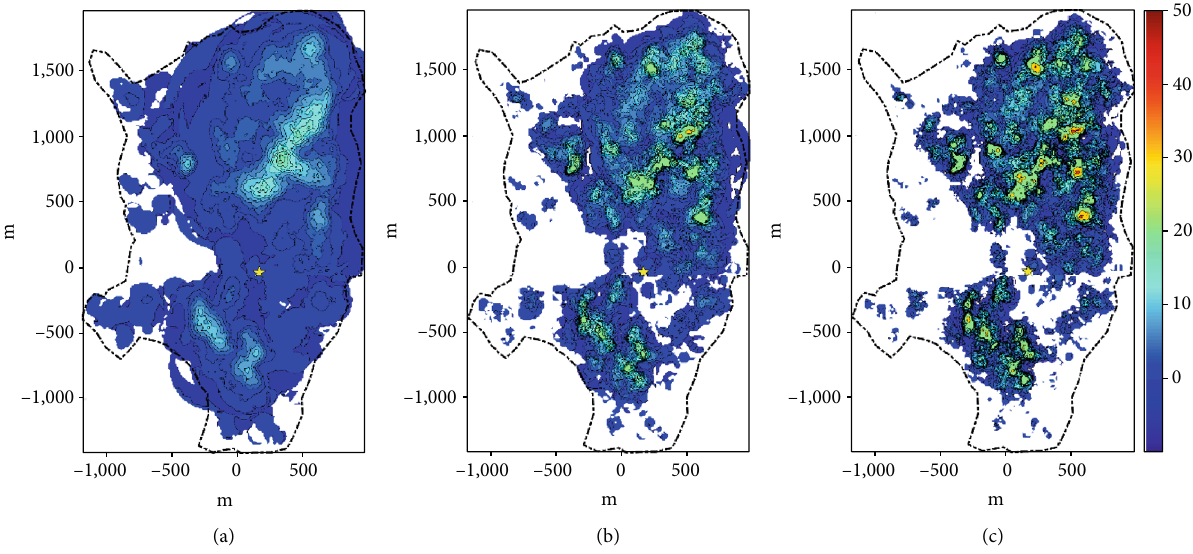
Figure 12: Spatial distribution of the maximum cumulative fl uid pressure changes inferred from repeated slip in top view of best- fi tting plane. The time at which the maximum cumulative fl uid pressure change is reached varies over the reservoir. Pressure changes are stated in megapascals according to the colour map, which is saturated at 50MPa. The yellow star denotes the fault intersection of the well Habanero#1. The arrow indicates northern direction. A constant stress drop of (a) 0.1MPa, (b) 0.5 MPa, and (c) 1.0MPa was assumed for determining fl uid pressure changes. Contour line denotes region of main seismic activity as outlined by the hypocentre distribution. Coordinates are given with respect to the top of Habanero#1.